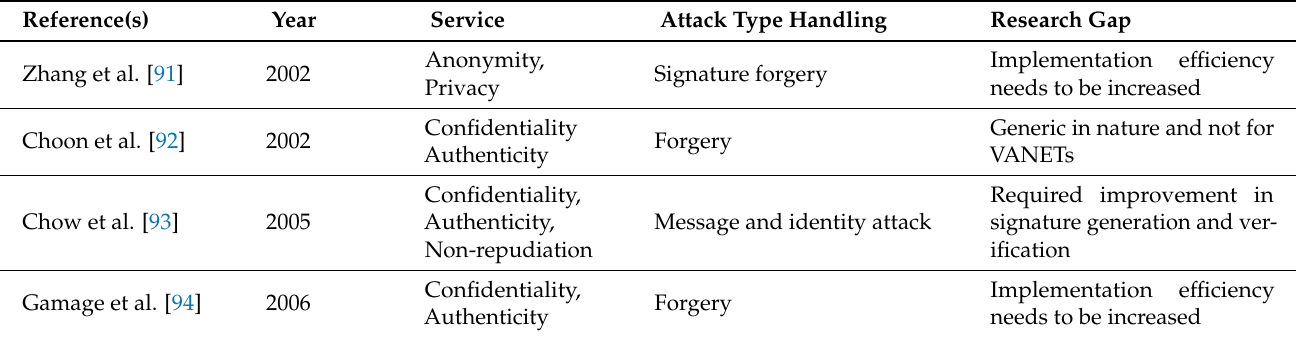
Table 5. List of ID-based solutions for